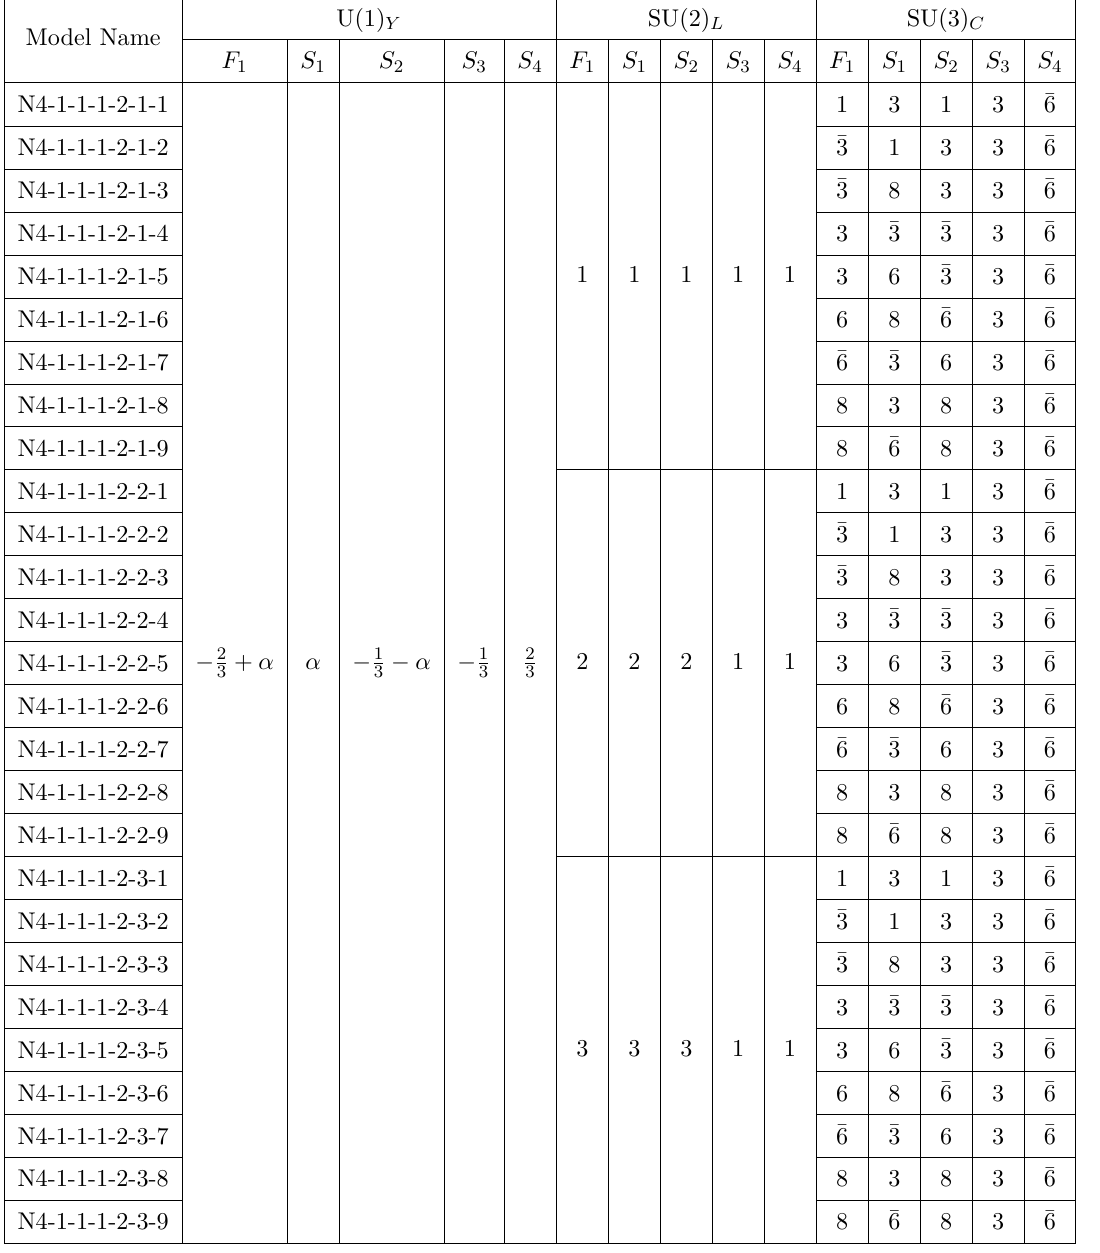
Table 7 . The one-loop models for the 0 νββ decay operator N4 arising from the diagram N4-1-1-1-2 shown in figure